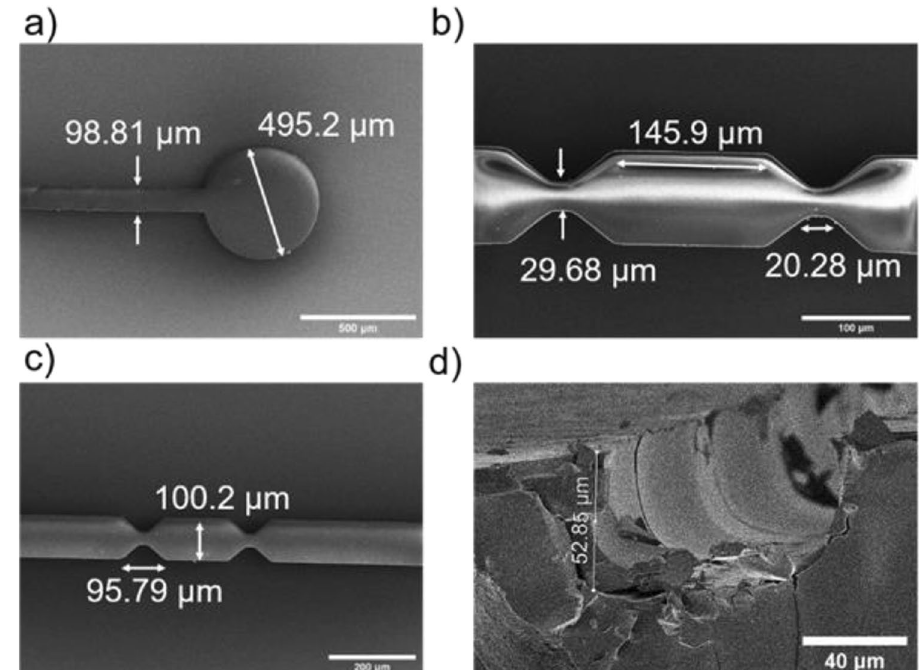
Figure 6. SEM micrographs of microfluidic channel fabricated in SU-8 after photolithography. ( a ) The inlet and outlet holes diameter of 500 µm and 100 µm microfluidic channel width, ( b , c ) Constricted sensing zone developed in SU-8 with comparable dimensions as defined in photomask, ( d ) Cross-sectional SEM image of PDMS microchannel created from SU-8 master stamp after soft lithography method.